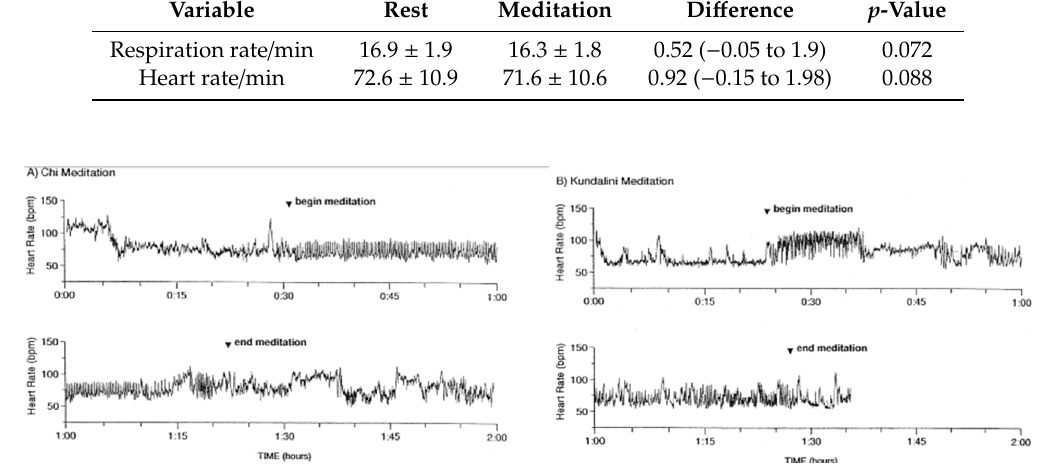
Figure 1. Heart rate changes during Chi and Kundalini meditation techniques [4].